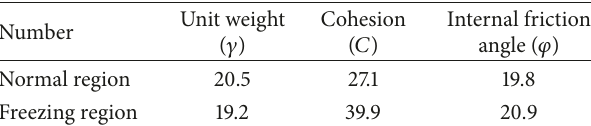
Figure 9: Slope stability analysis of Wulin open-pit mine. Table 3: Physicomechanical parameters of normal and freezing region.